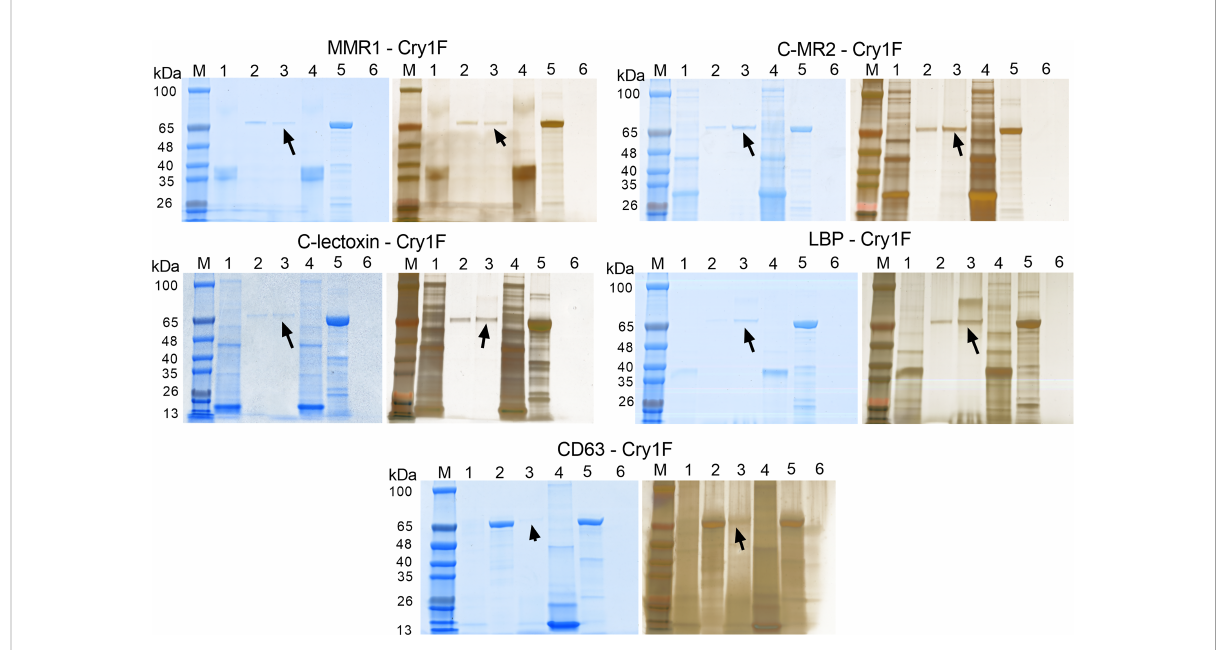
FIGURE 6 Pull-down assays testing protein-protein interactions (PPI) between Cry1F, C-type lectins and tetraspanin. Each panel presents SDS-PAGE gels initially stained with FastBlue Protein stain (left) and further stained using ProteoSilver silver staining kit (right). Lanes M - TrueColor protein marker, Lanes 1 - Bait fl owthrough, Lanes 2 - Prey fl ow through, Lanes 3 - Final elution, Lanes 4 - Puri fi ed bait protein, Lanes 5 - Prey protein (activated Cry1F) and Lanes 6 - Non-treated control. The arrow mark indicates detection of Cry1F protein in the elution, supporting interaction with immobilized bait proteins. ACB proteins tested: Macrophage mannose receptor 1-like (MMR1), C-type mannose receptor 2-like (C-MR2), CD209 antigen-like protein E (CD209), C-type lectin lectoxin-Phi1-like (C-lectoxin), hemolymph lipopolysaccharide-binding protein (LBP), and CD63 antigen-like (CD63 - ectodomain